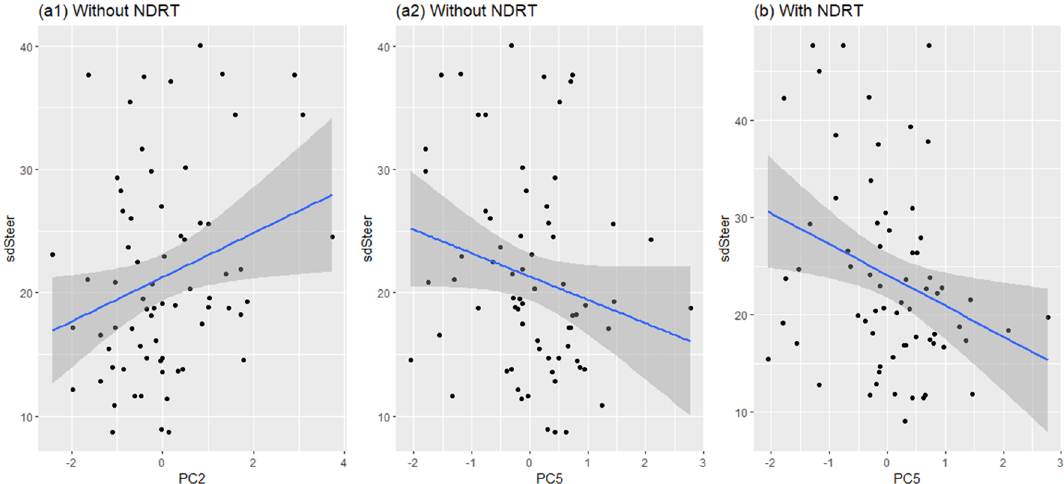
Figure 4. Scatterplots showing the correlations of standard deviations of steering wheels (sdSteer) and different components of ( a1 ) PC2 without NDRT, ( a2 ) PC5 without NDRT, and ( b ) PC5 with NDRT. Blue lines indicate linearly fitted smooth lines, and shades around lines present 95% confidence intervals. PC2: principal component 2, PC5: principal component 5, NDRT: non-driving related